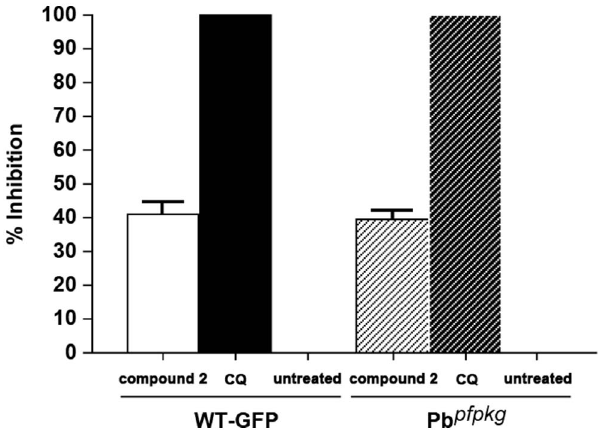
Figure 5. Invivo blood stage efficacy test using compound 2. A Peters 4 days test was carried out using both WT-GFP and transgenic Pb pfpkg with the PKG inhibitor compound 2. Both WT-GFP and Pb pfpkg transgenic parasites showed a 40% reduction in blood stage parasitaemia with compound 2 given at 25 mg/kg twice daily via the oral route. Chloroquine (CQ) was used as control showed a 100% reduction in blood stage parasitaemia in mice after a single daily oral dose of 10